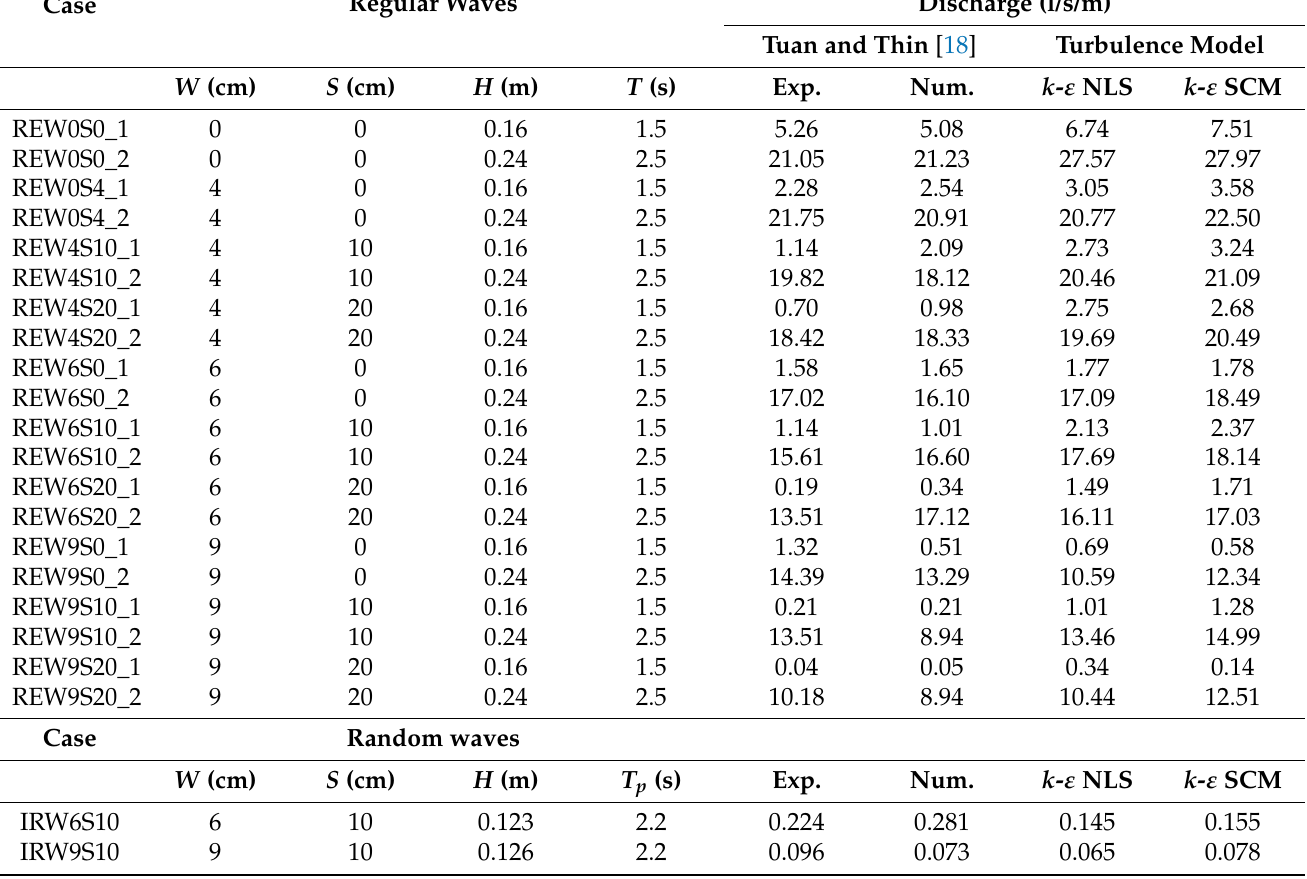
Table 4. Average wave overtopping discharge of regular (RE) and random (IR) waves: experimental and numerical from Tuan and Thin [18] and numerical predictions for k - ε NLS and k - ε SCM turbulence